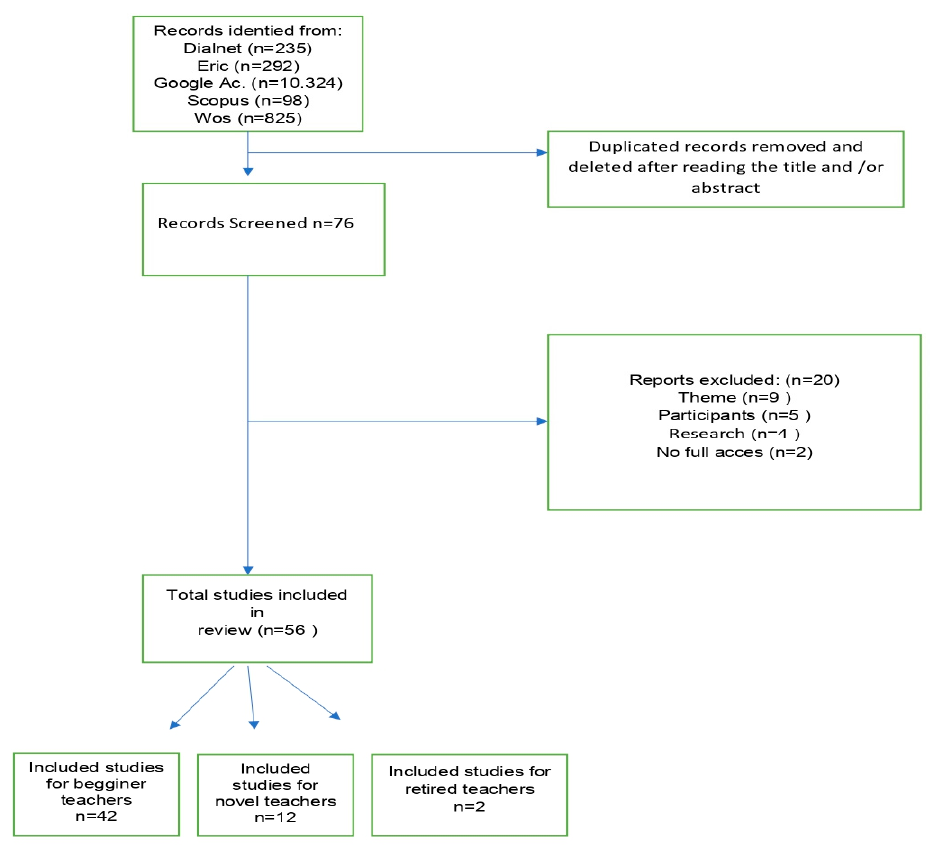
Figure 2. Selection flow of the articles included in the systematic review.